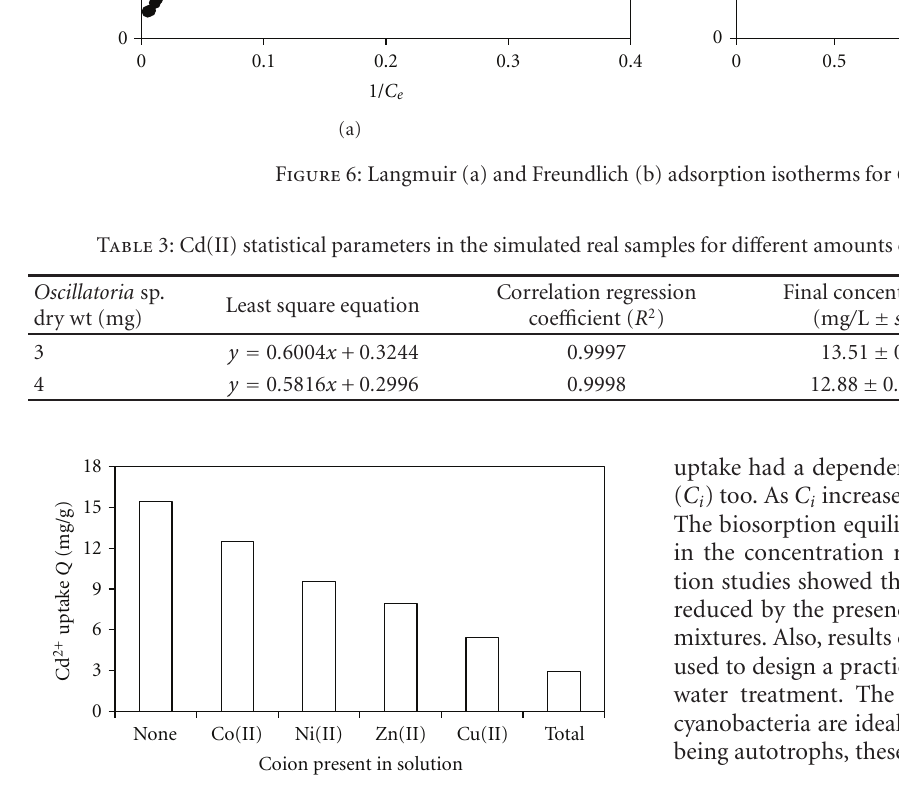
Figure 7: E ff ect of coions on the uptake of Cd(II) by dried biomass at initial concentration of cadmium 10 ppm; temperature 25 ◦ C; pH 7; initial concentration of coions (equimolar): Ni 2+ : 2.9 ppm; Cd 2+ : 5.5 ppm; Cu 2+ : 3.1 ppm; Zn 2+ : 3.3